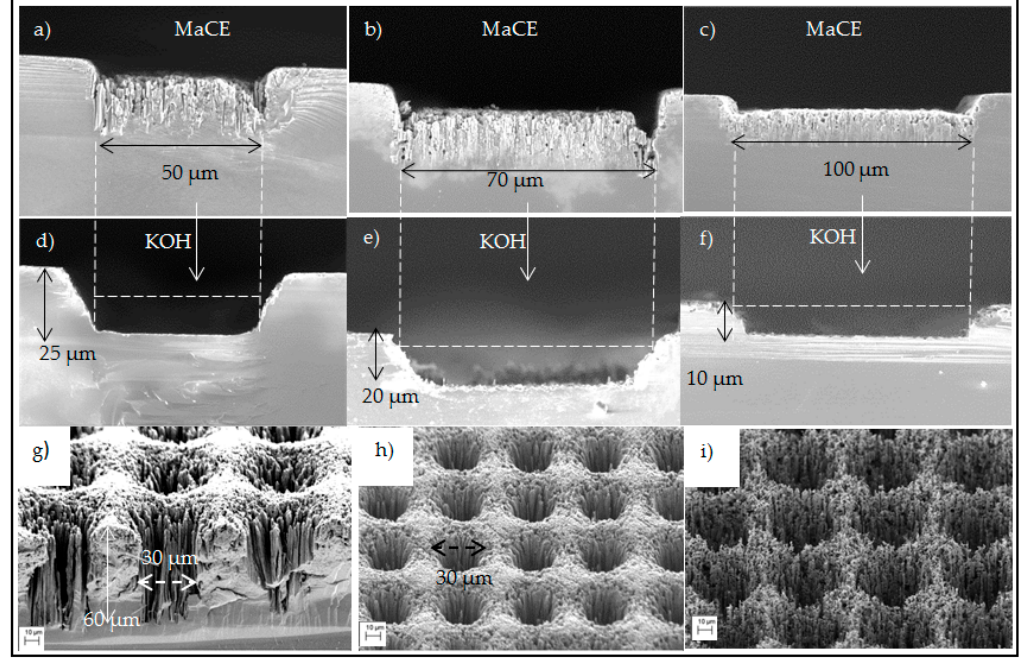
Figure 5. SEM images of printed channels, ( a – c ) after MaCE and ( d – f ) after KOH etching; ( g ) Cavities after 60 min MaCE and ( h ) after 1 min KOH etching; ( i ) Highly rough surface of the same sample due to increasing the time of KOH etching to 3 min. Dashed lines show the width of printed silver patterns.